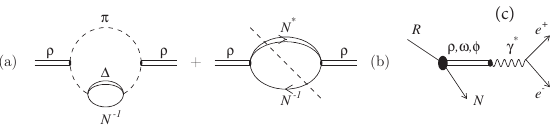
Figure 2. Schematic presentation of main graphs entering in- medium calculation of the ρ meson spectral function (a,b) and the relation to the elementary process of Dalitz decay of baryon resonance (c).